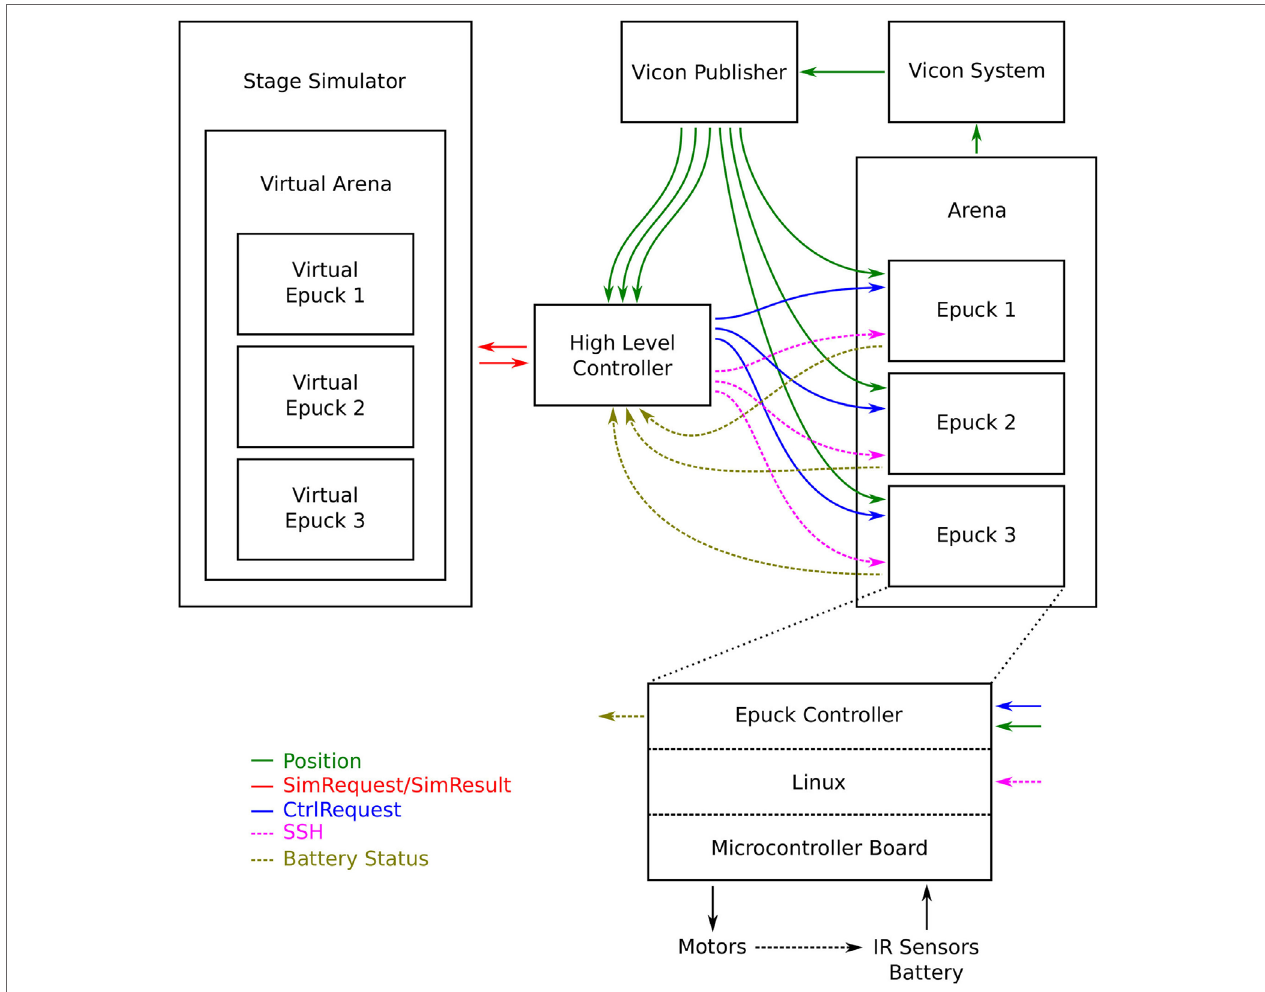
FigUre 11 | Flowchart of the complete experimental system including all the logging, book-keeping, and status messages used for experimental control and logging. This diagram not only contains all the elements needed for the CE but also all elements needed for automated experimentation so there are more control- and logging messages than would be needed for the operation of the